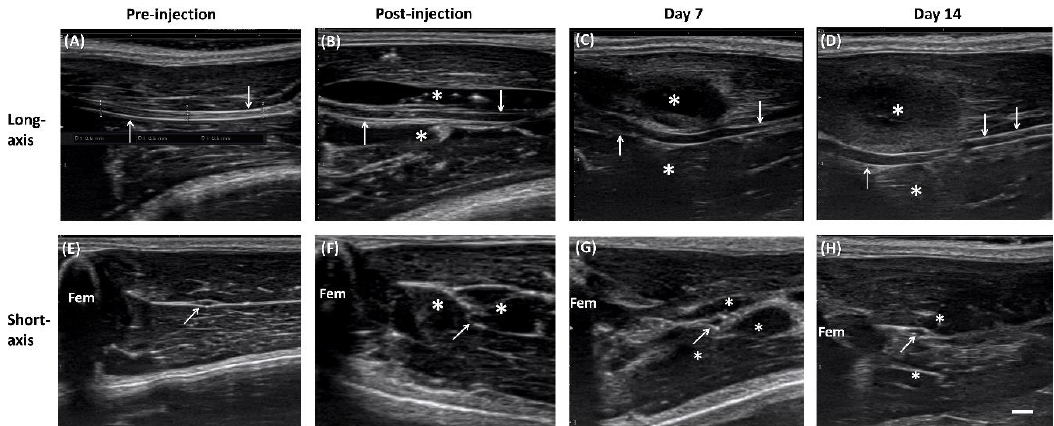
Figure 2. Sonography of sciatic nerve before and after injection. Long-axis ( A – D ) and short-axis ( E – H ) views of the sciatic nerve (arrows) before, immediately after, and 7 days and 14 days after hydrogel (asterisk) injection (Scale bar: 1 mm).